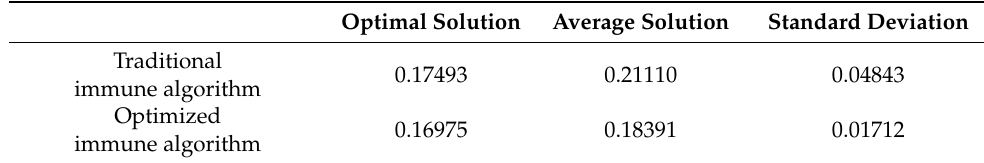
Table 4. The comparison of search accuracy and stability performance.